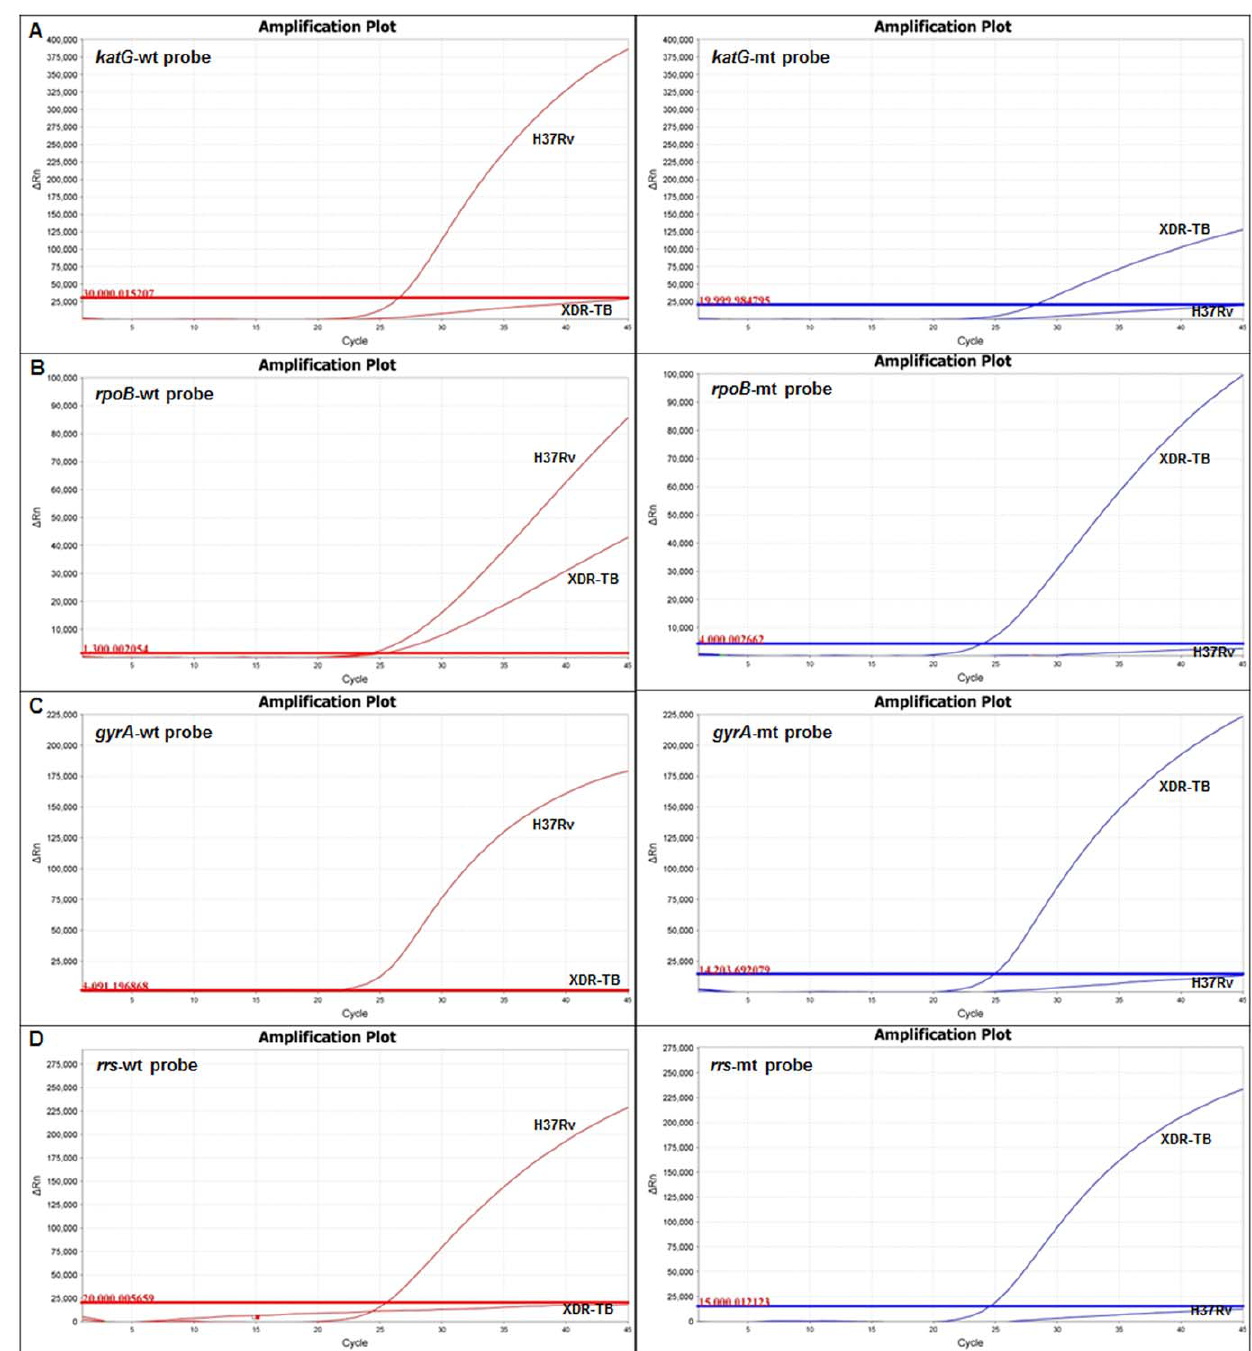
Figure 1. Specificity of real-time PCR probes. Each probe was evaluated with singleplex PCR using purified wild-type (H37Rv) or mutant (XDR- TB) DNA template. Wild-type probe is shown in red, mutant probe in blue. Thresholds for positivity are shown as horizontal lines. All probes were highly specific for cognate DNA sequence, except that the rpoB wild-type probe showed significant cross-reactivity. Both katG probes, both rrs probes, the rpoB mutant probe, and the gyrA mutant probe displayed minimal cross-reactivity with the opposing template.